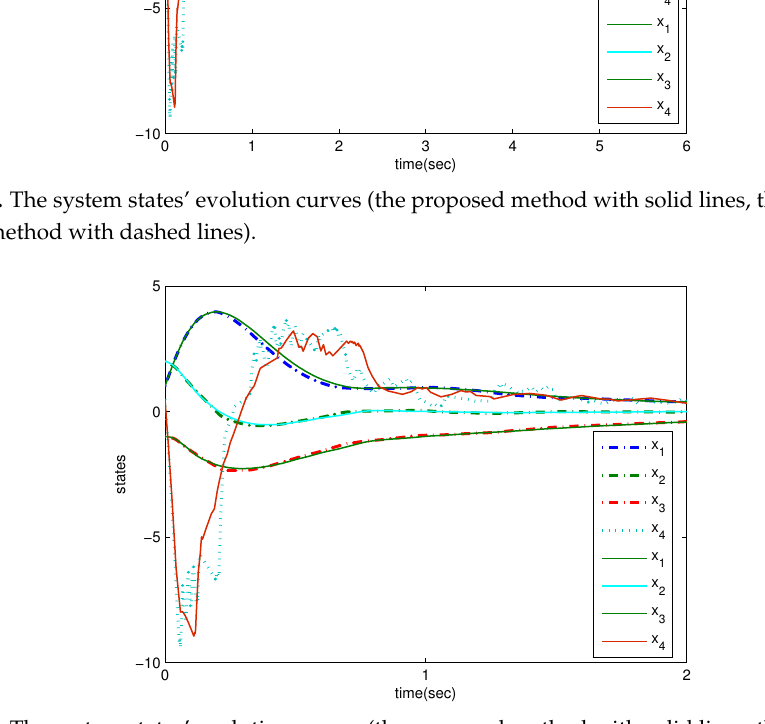
Figure 3. The system states’ evolution curves (the proposed method with solid lines, the memoryless design method with dashed lines).